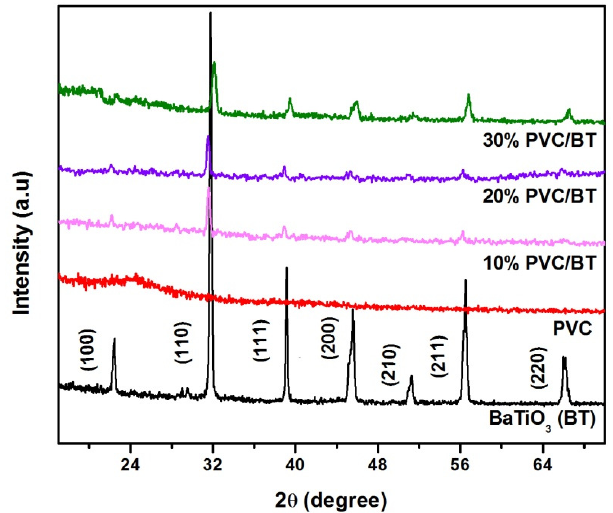
Figure 2. XRD patterns of BT, PVC and PVC/BT composites with various BT content in PVC ma- trix.